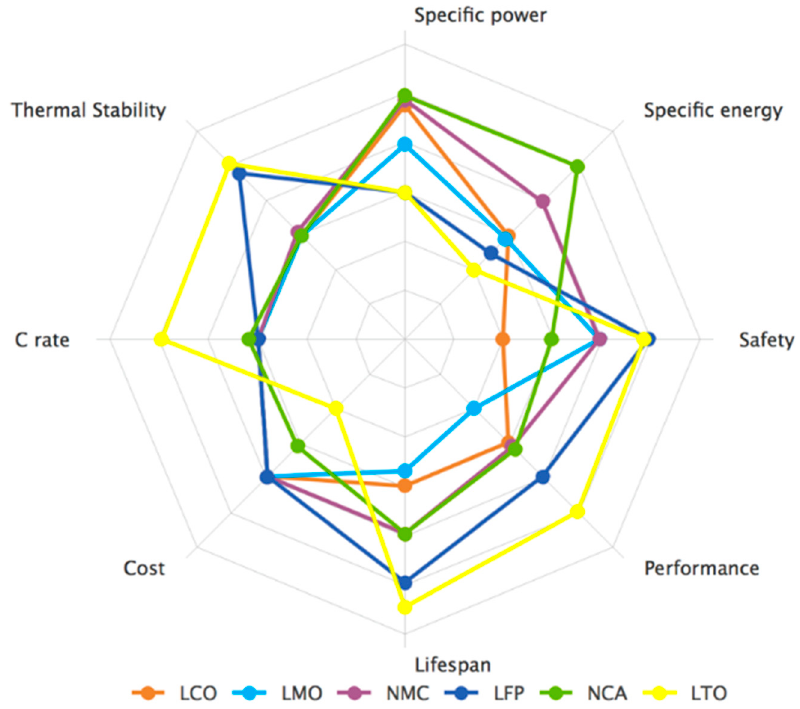
Figure 1. Spider chart for LIBs with various anode and cathode materials.